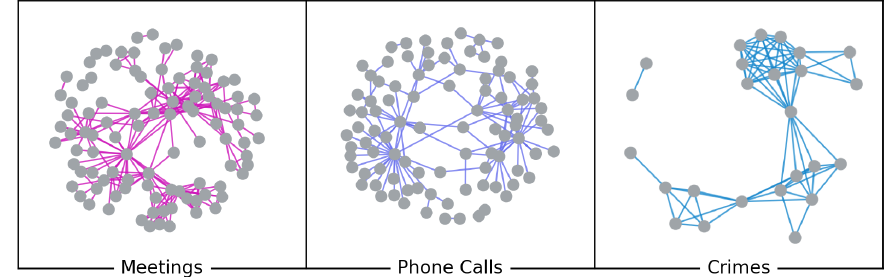
Figure 1. Multiple layers representing different kinds of relationships, i.e., meetings (violet), phone calls (blue), and crimes (light blue), among suspects in the Montagna operation.